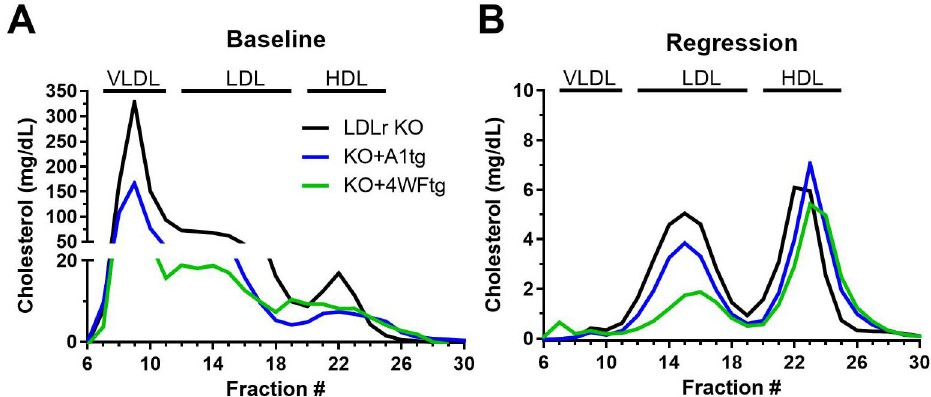
Fig 4. FPLC lipoprotein profile of male mice at the baseline time point on the western-type diet (A) and 7 weeks after starting the regression diet (B). Cholesterol concentrations in each 0.5 ml fraction shown, note the scale difference between the progression and regression panels. Black line, LDLr KO mice; blue line, LDLr KO expressing the wild type human apoA1 transgene; and green line, LDLr KO expressing the 4WF human apoA1 transgene.